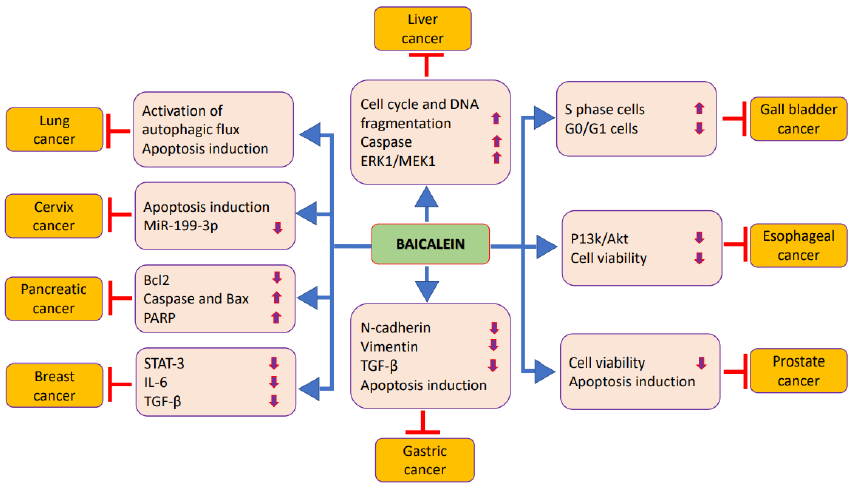
Figure 3. Role of baicalein in different types of cancer.